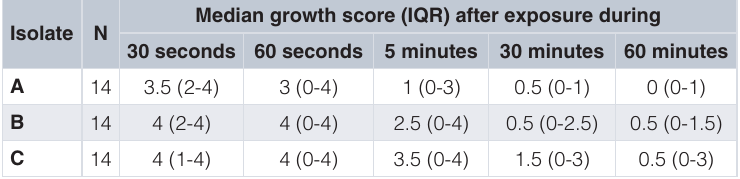
Table 5. Growth of Neisseria gonorrhoeae after exposure to seven potential placebo mouthwashes (Biotene ® and Placebo 1-6).